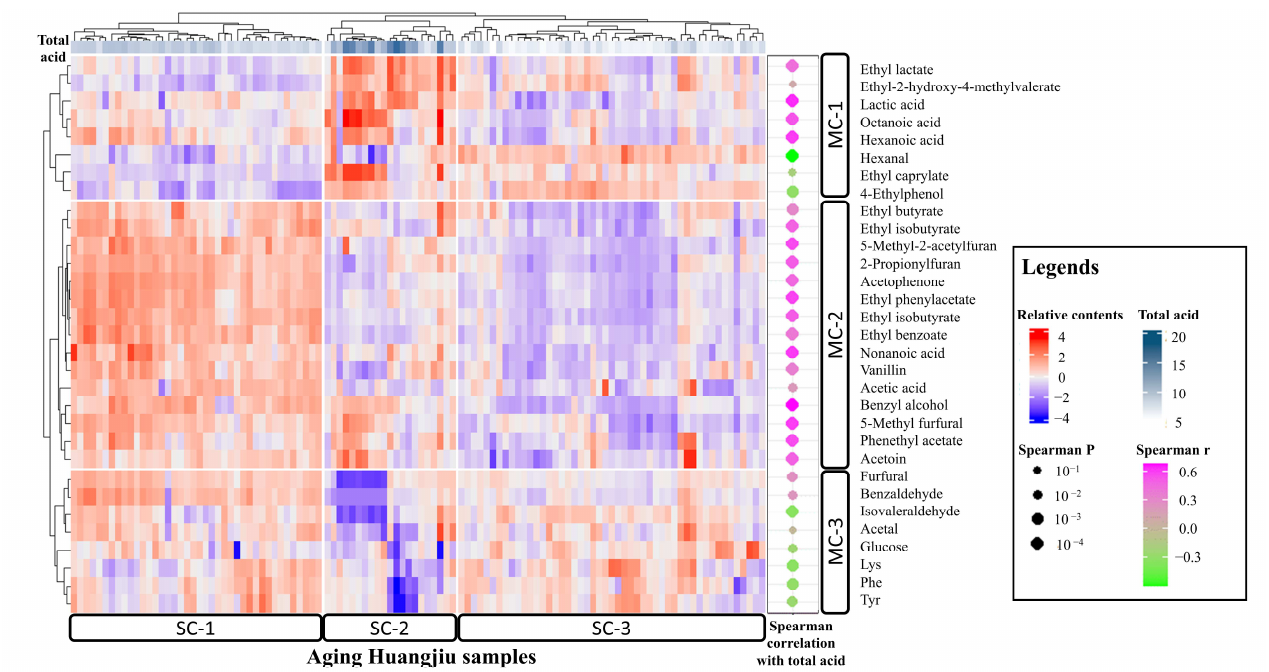
Figure 5. Cluster map of relative contents of metabolites that were well predicted by PI model (explained variance > 0.3). MC: Metabolite Cluster; SC: Sample Cluster.